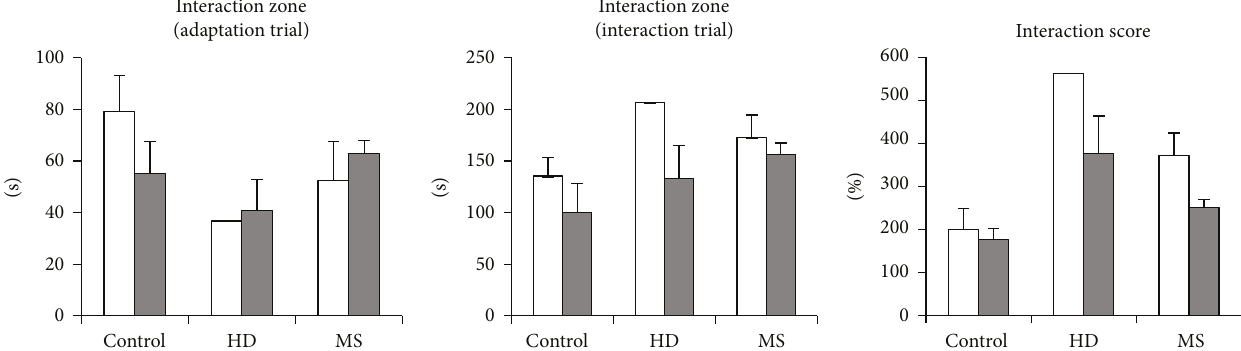
Figure 8: The in fl uence of early-life stress on the behavior of adult female mice in social interaction test in di ff erent phases of estrous cycle. Data present as mean ± standard error of the mean (SEM). White box: estrus (5 control females, 1 HD group, and 4 MS group), gray box: diestrus (6 control females, 5 HD group, and 4 MS group). Insu ffi cient number of mice in each phase did not allow a correct statistical